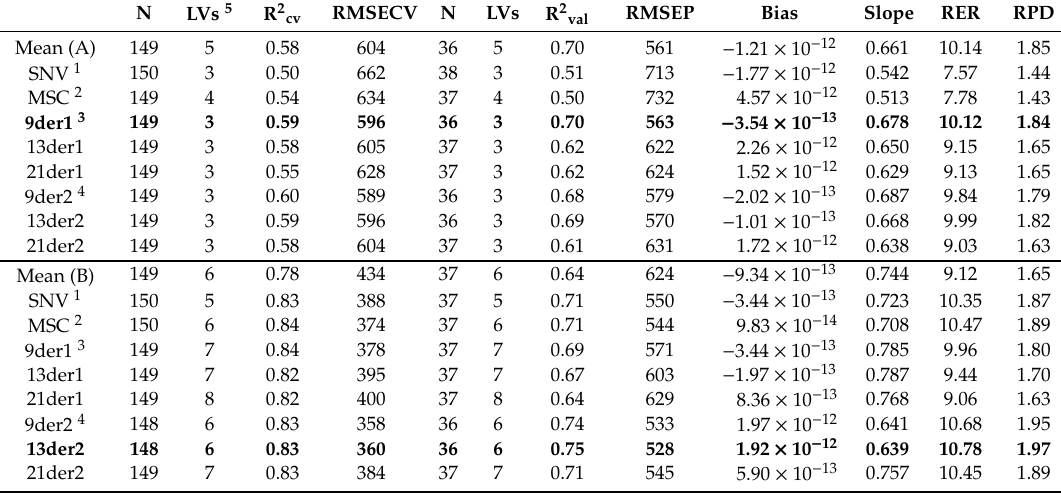
1 Standard normal variate; 2 multiplicative scatter correction; 3 Xder1: first derivative with X number of smoothing points; 4 Xder2: second derivative with X number of smoothing points; 5 number of latent variables. The best model for GCV ad prediction on WD st was developed using first derivative